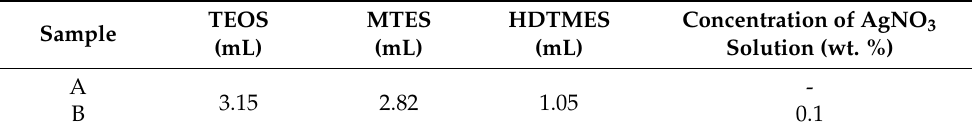
Table 1. Reagents used for synthesis of silica material (sample A) and silver-based silica material (sample B).